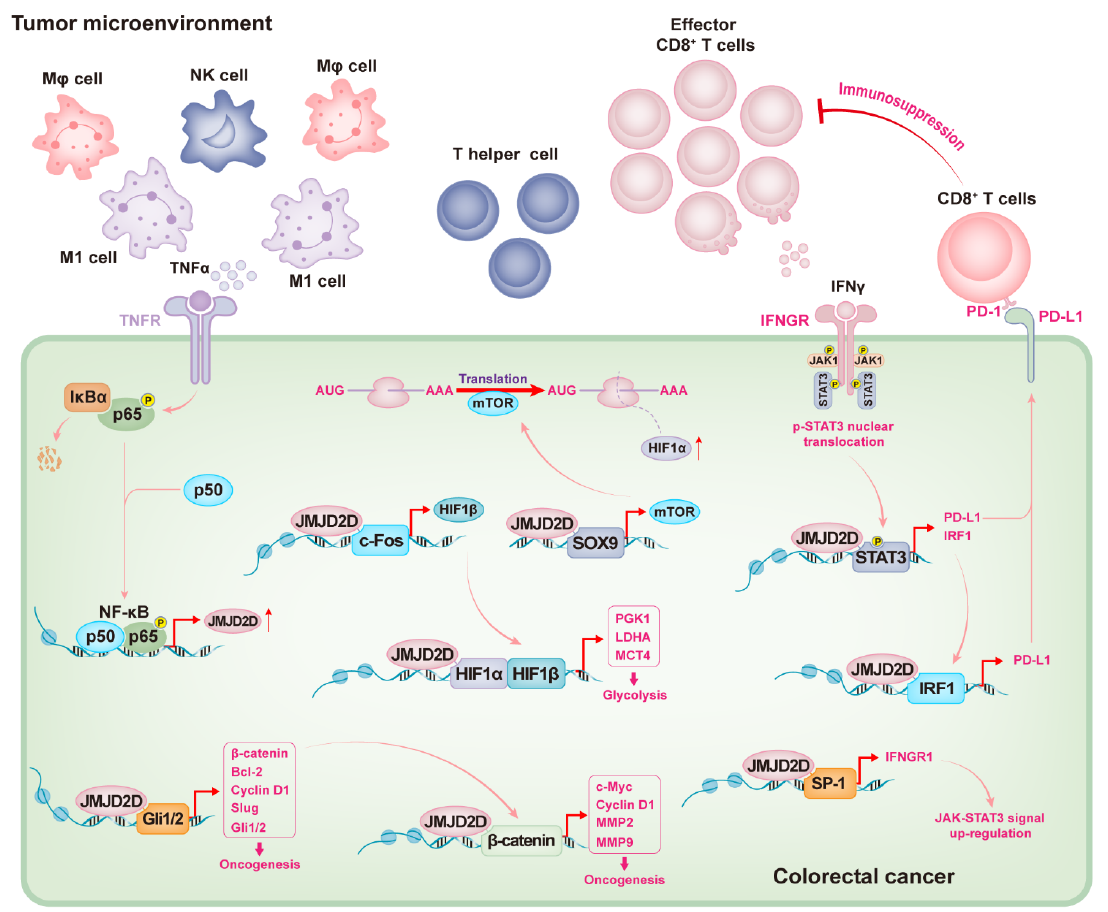
Figure 3. Overview of the mechanisms by which JMJD2D promotes CRC progression. Intestinal inflammation can trigger immune cells to release TNF α to upregulate JMJD2D in colorectal cells by activating NF- κ B signaling. Highly expressed JMJD2D cooperates with Gli1/2 and β -catenin to promote the expression of various oncogenes, resulting in tumorigenesis. JMJD2D cooperates with c-Fos and SOX9to promote the expression of HIF1 α and HIF1 β , respectively. Subsequently, JMJD2D serves as a coactivator to promote the transcription of tumor glycolysis-related genes by elevating the HIF1 α / β signaling. Again, JMJD2D cooperates with SP-1 to promote the expression of IFNGR1, which helps to maintain the signal that IFN γ triggers the upregulation of PD-L1 through the JAK-STAT3 pathway. Importantly, JMJD2D can cooperate with STAT3 and IRF1 to promote PD-L1 transcription. Subsequently, tumor cells antagonize the activation and effector functions of CD8 + T cells by activating PD-1/PD-L1 inhibitory signals through highly expressed PD-L1.